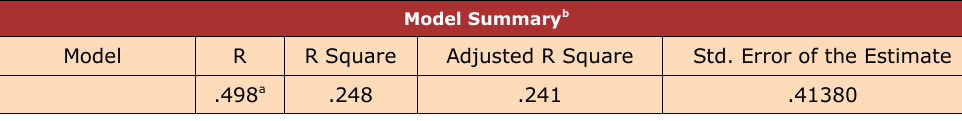
Table 3. Correlation among SI and OCB